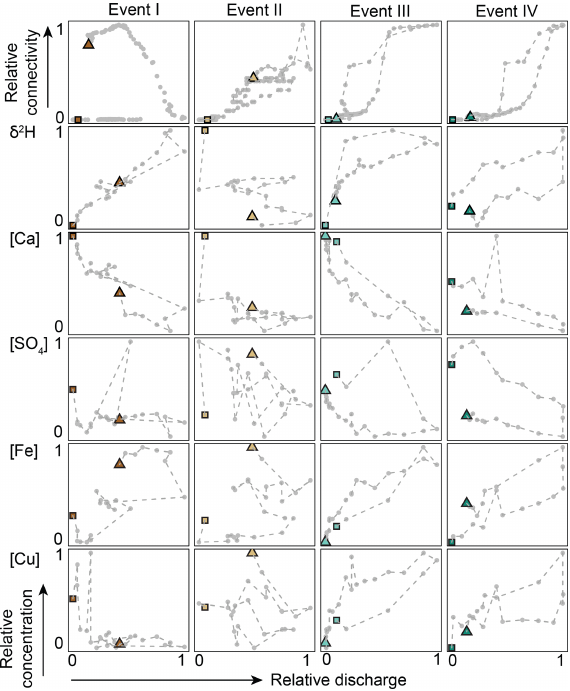
Figure 5. Relationship between the fraction of the catchment that was connected (relative connectivity) and discharge (top row), and concentration–discharge relationships for δ 2 H, calcium, sulfate, iron and copper (rows 2–6) for events I–IV (columns). Individual samples are marked with a grey dot and connected with a broken line. The first sample of the event is indicated by a square and the last sample by a triangle. All data are normalised between 0 (min- imum measured value for the event) and 1 (maximum measured value for the event) for better visualisation of the hysteretic rela- tionship. Figure 6. Dendrogram for the hierarchical clustering of solutes and